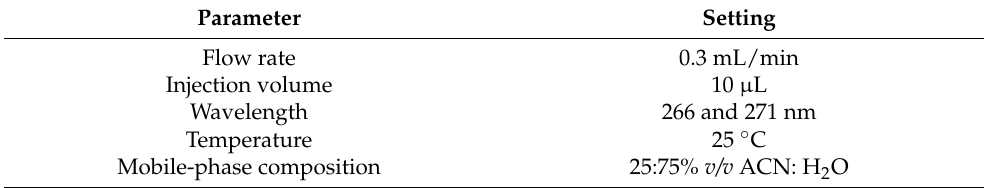
Table 4. Chromatographic conditions for the analysis of zidovudine (AZT) and lamivudine (3TC) [66]. Parameter Setting Flow rate 0.3 mL/min Injection volume 10 µ L Wavelength 266 and 271 nm Temperature 25 ◦ C Mobile-phase composition 25:75% v/v ACN: H 2